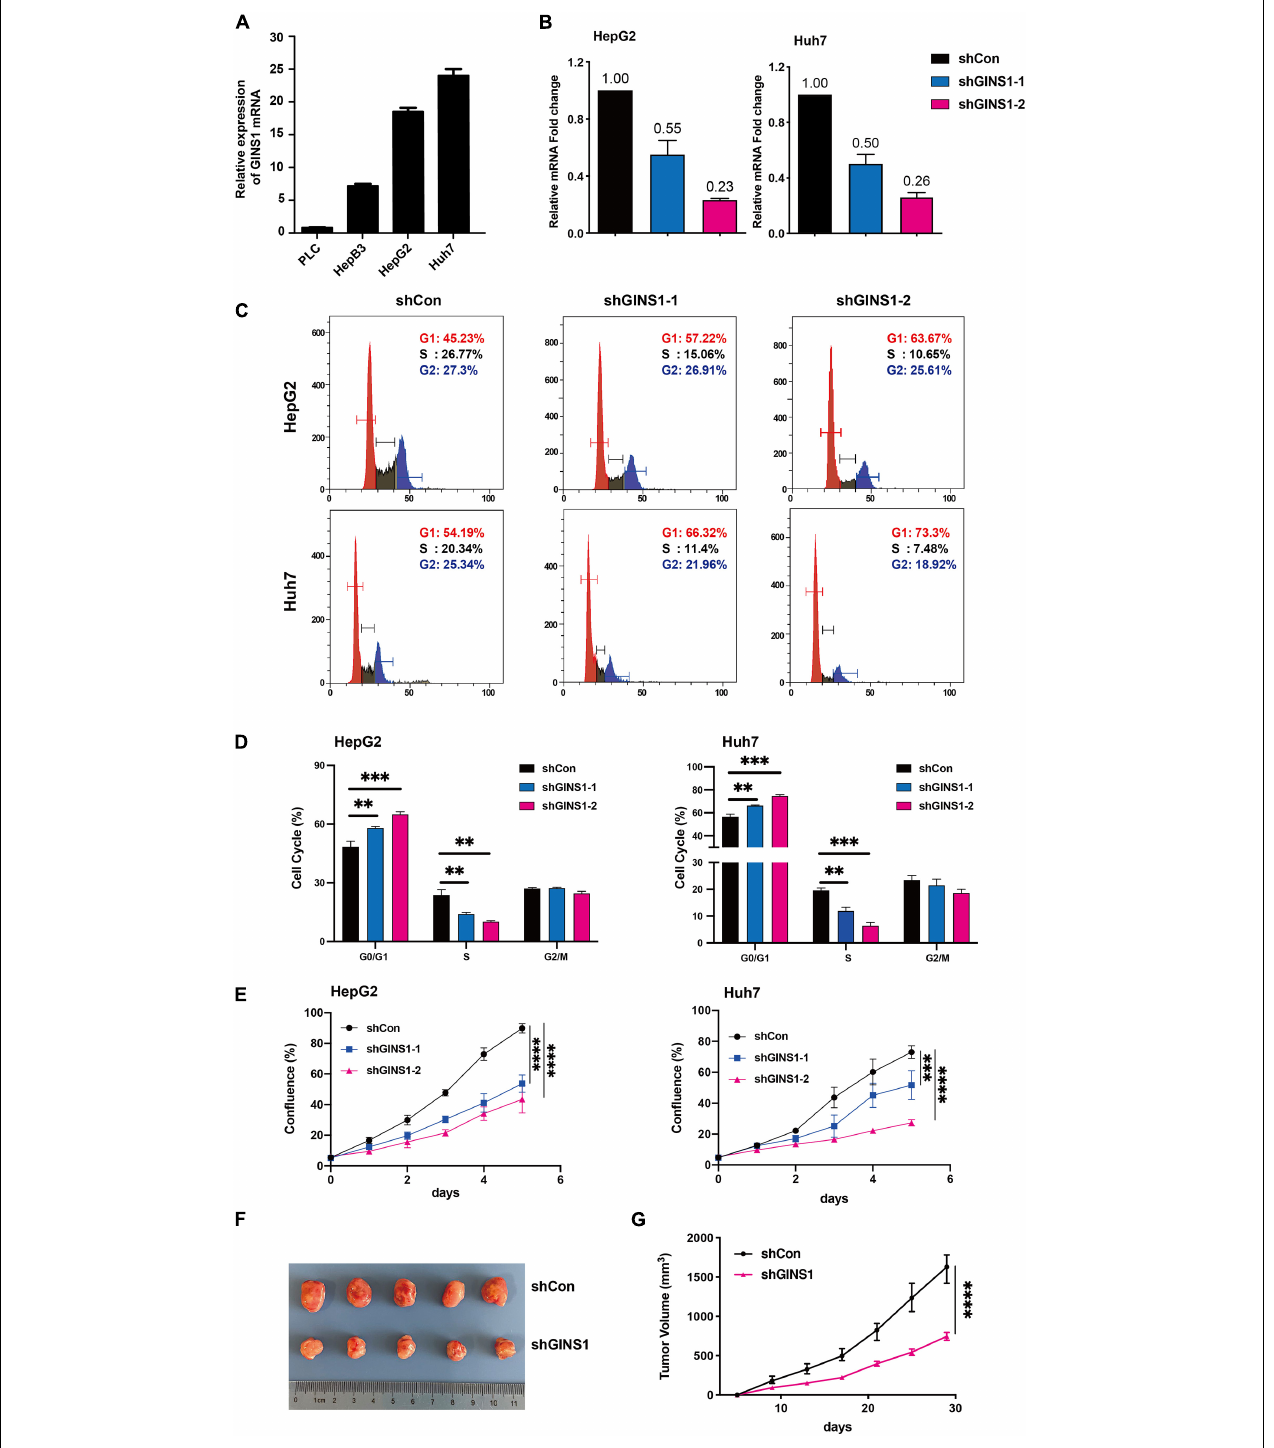
FIGURE 2 | Cell cycle and proliferation regulated by GINS1 in HCC cells. (A) transcription level of GINS1 in HCC cells was detected by RT-qPCR. (B) transcription level of GINS1 in HepG2 (left panel) and Huh7 (right panel) cells stably silenced with GINS1 short hairpin RNA (shGINS1) or control shRNA (shCon) was measured by RT-qPCR. (C,D) cell cycles of stable transfected HepG2 and Huh7 cells were measured by flow cytometry and quantified (mean ± SD). (E) cell proliferations of HepG2 (upper panel) and Huh7 (lower panel) cells w/o GINS1 knockdown were assessed by IncuCyte. (F) representative micrograph showing tumor formation in BALB/c mice injected subcutaneously (s.c.) with Huh7 shGINS1 or shCon tumor cells. (G) Growth curves of the two groups in (F) . Data are presented as mean ± SD. ∗∗ P < 0.01; ∗∗∗ P < 0.001; and ∗∗∗∗ P < 0.0001.